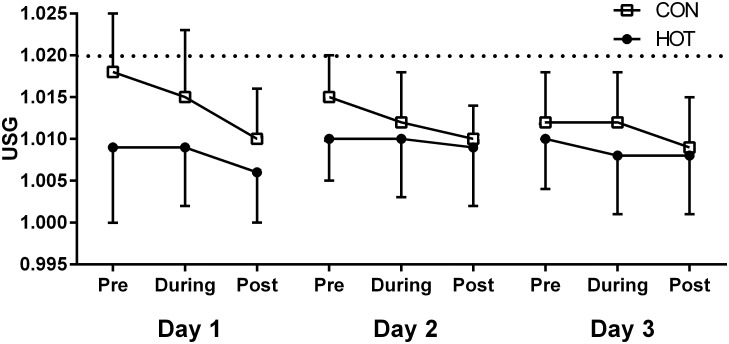
Pre, during, and post-shift USG values over the three days.* The dotted line denotes that the threshold for dehydration is > 1.020.